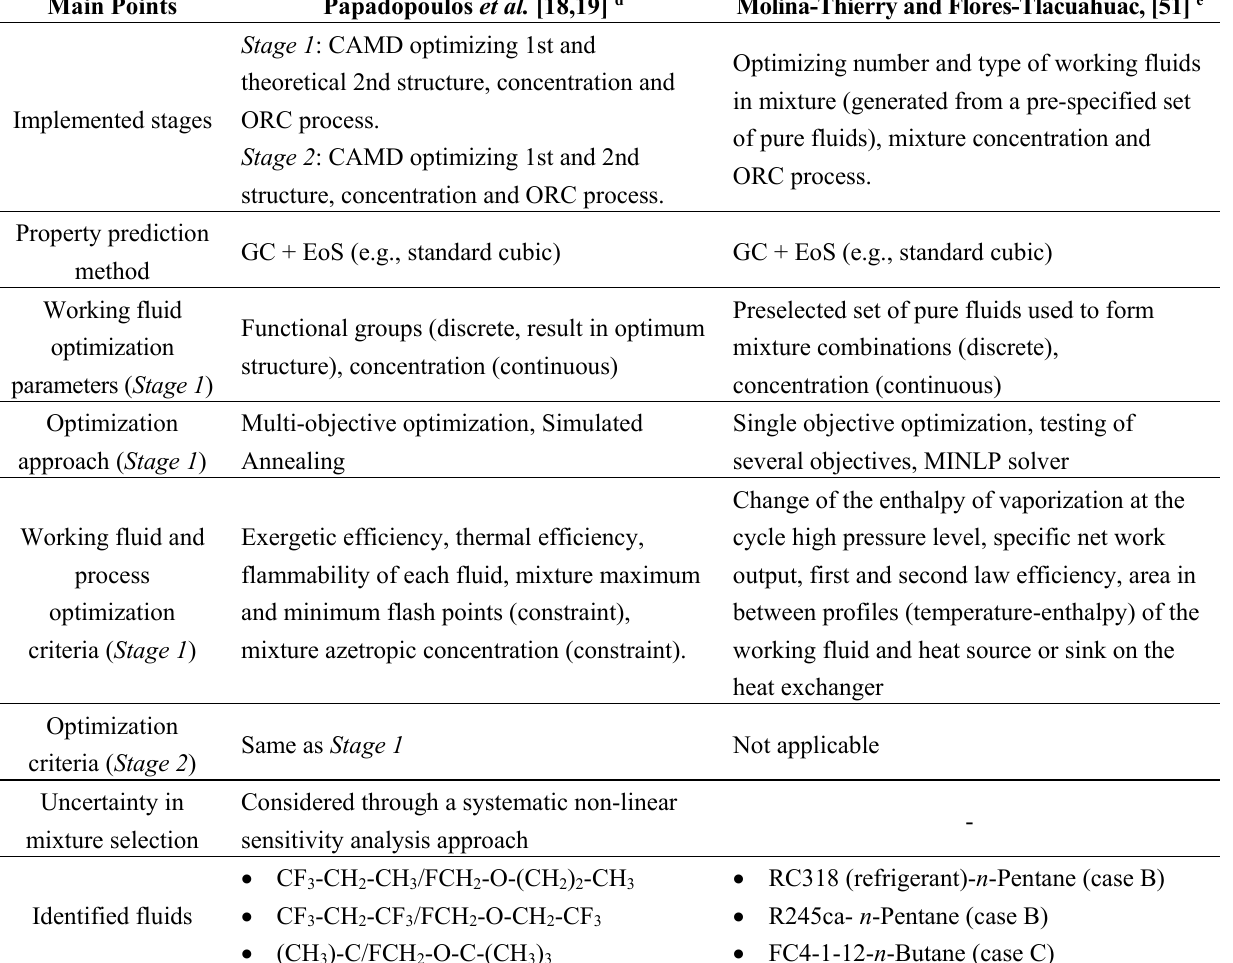
Figure 4. Algorithmic steps involved in the optimization-based CAMD approach for simultaneous mixture and ORC design used in Papadopoulos et al. [18,19]. Table 2. Main points in methods for optimum design and selection of ORC working fluid